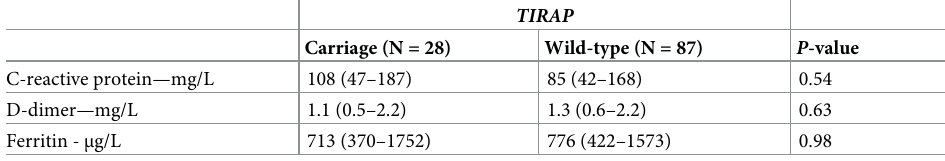
Table 6. Biochemical parameters in patients with TIRAP carriage and TIRAP